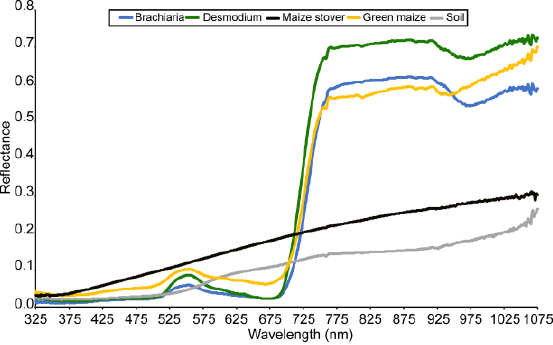
Figure 2. Mean canopy spectra of the ‘push-pull’ system